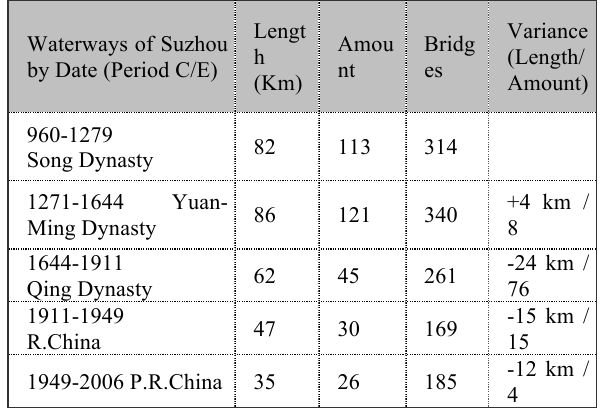
Table 1. Data of waterways by period in past researches coordinated by